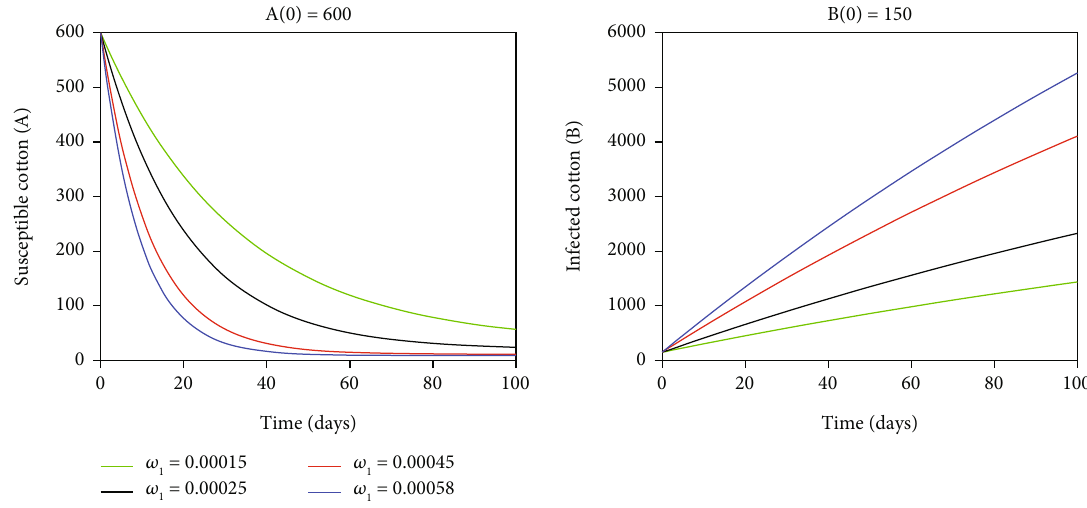
Figure 4: Susceptible cotton population (A) and infected cotton population (B) w.r.t. time t for di ff erent values of ω